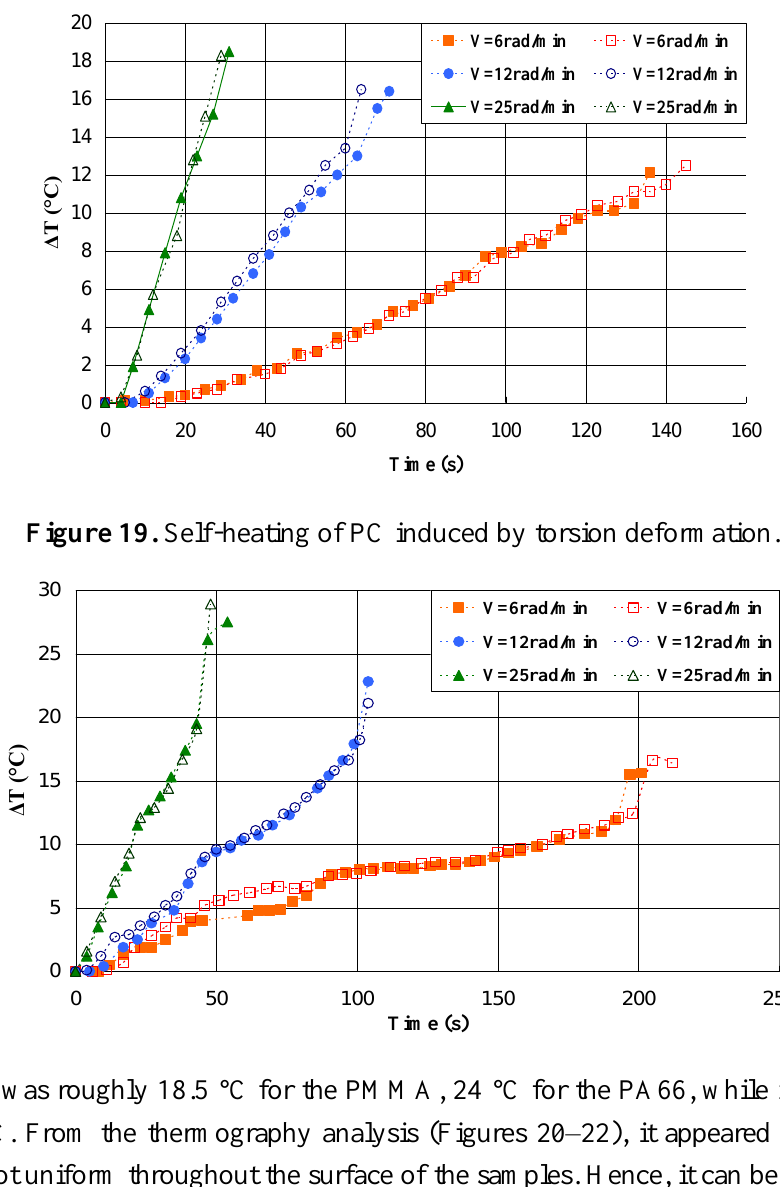
Figure 18. Self-heating of PMMA induced by torsion deformation.